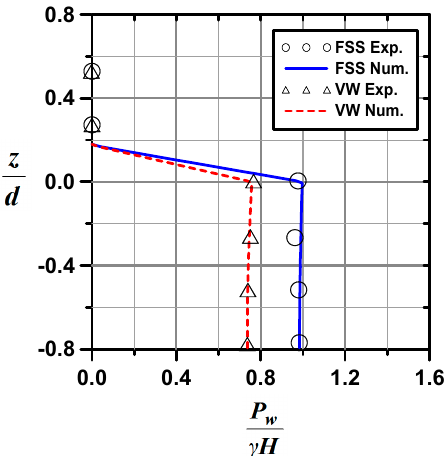
Figure 4. Distribution of the maximum wave pressure on the FSS and VW seawall. Experimental data of FSS seawall ( ○ ) and VW seawall ( △ ) ([38]). The results of present numerical model of FSS seawall (-) and VW seawall (- -).